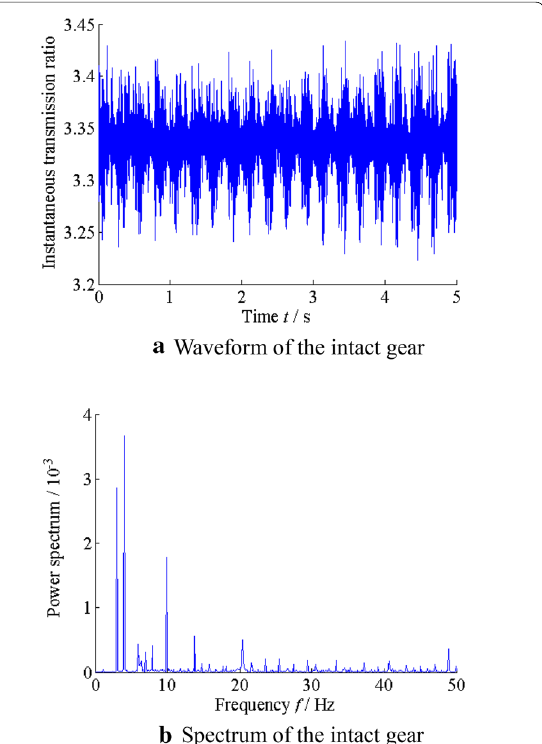
Figure 13 Signal of instantaneous transmission ratio for the intact gear. a Waveform of the intact gear, b Spectrum of the intact